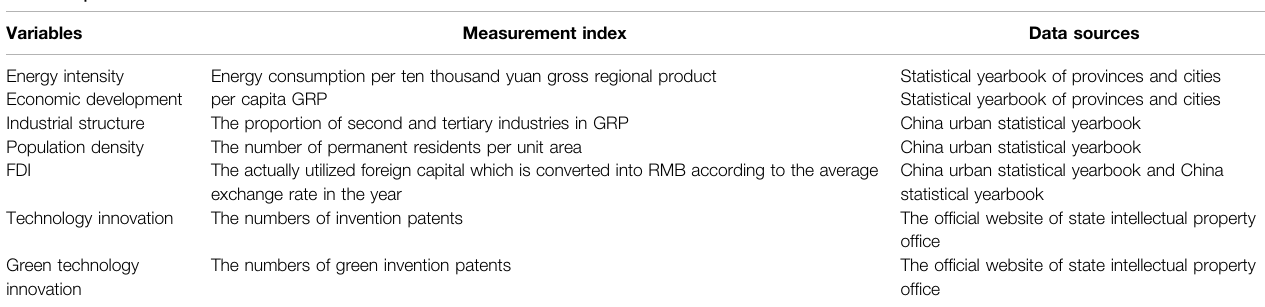
TABLE 1 | Variable measurement and data